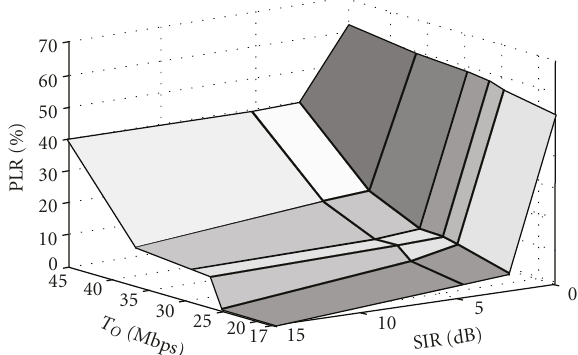
Figure 6: Unicast video streaming, additional data tra ffi c, and AWGN interference: PLR versus SIR and T O .